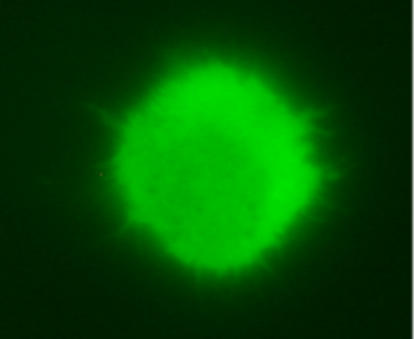
Lentiviral transduced dendritic cells